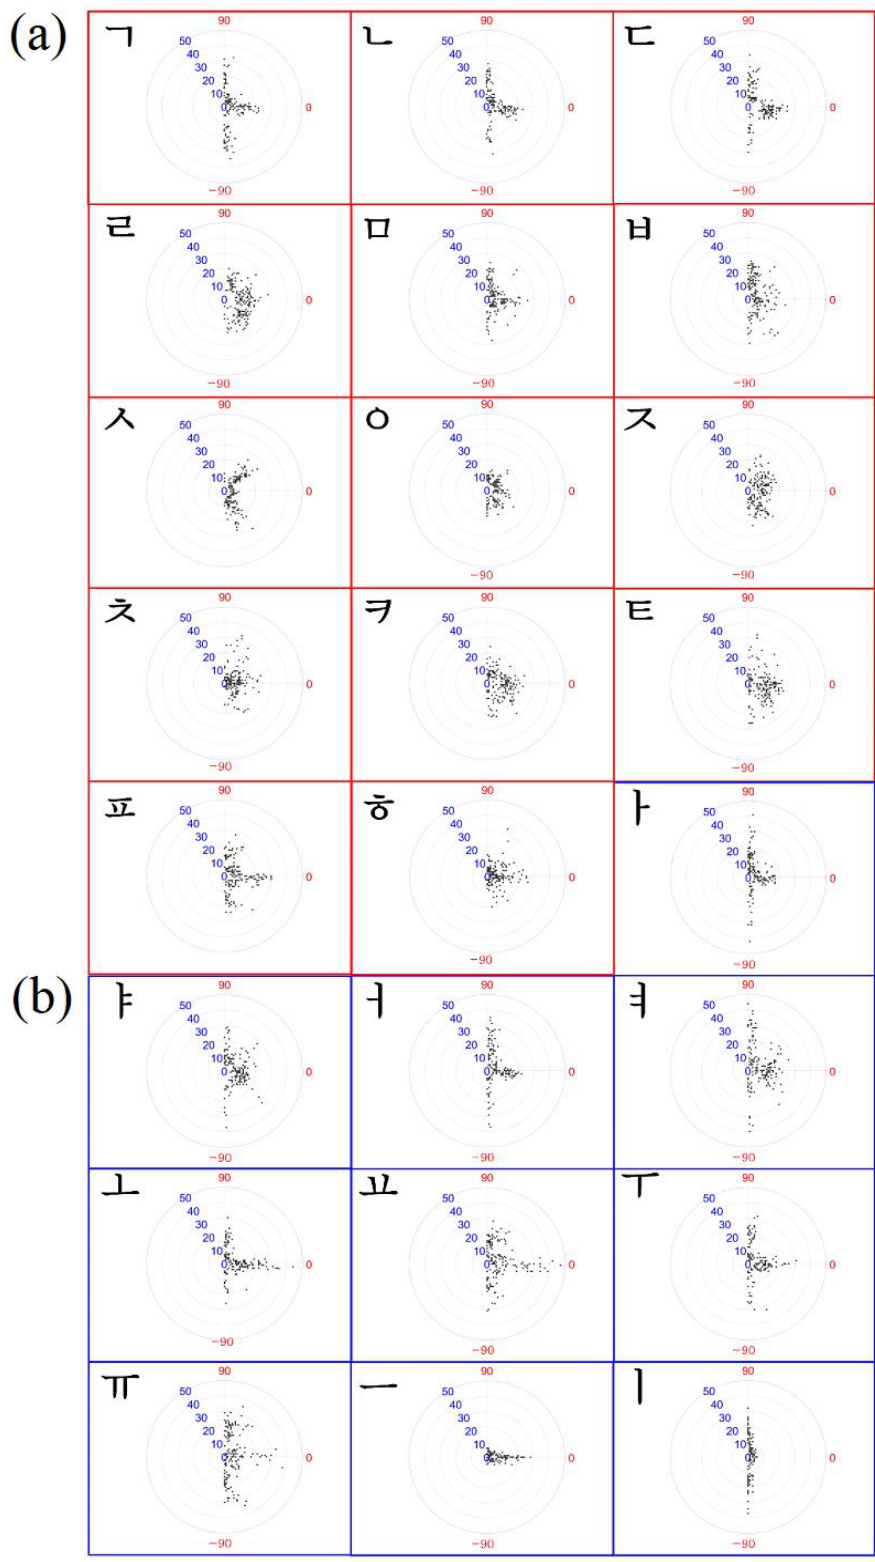
Figure 4. This represents the cloud of line distribution (COLD) results for a tablet writing test, featuring results for each consonant and each vowel, where ( a ) shows 14 consonant results (which is covered red line) and ( b ) shows 10 vowel results (which is covered blue line).